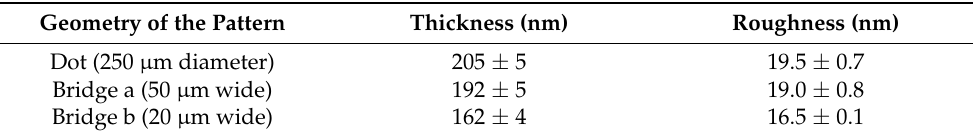
Table 1. Morphological properties of the nanostructured zirconia in different pattern features on the sample. Geometry of the